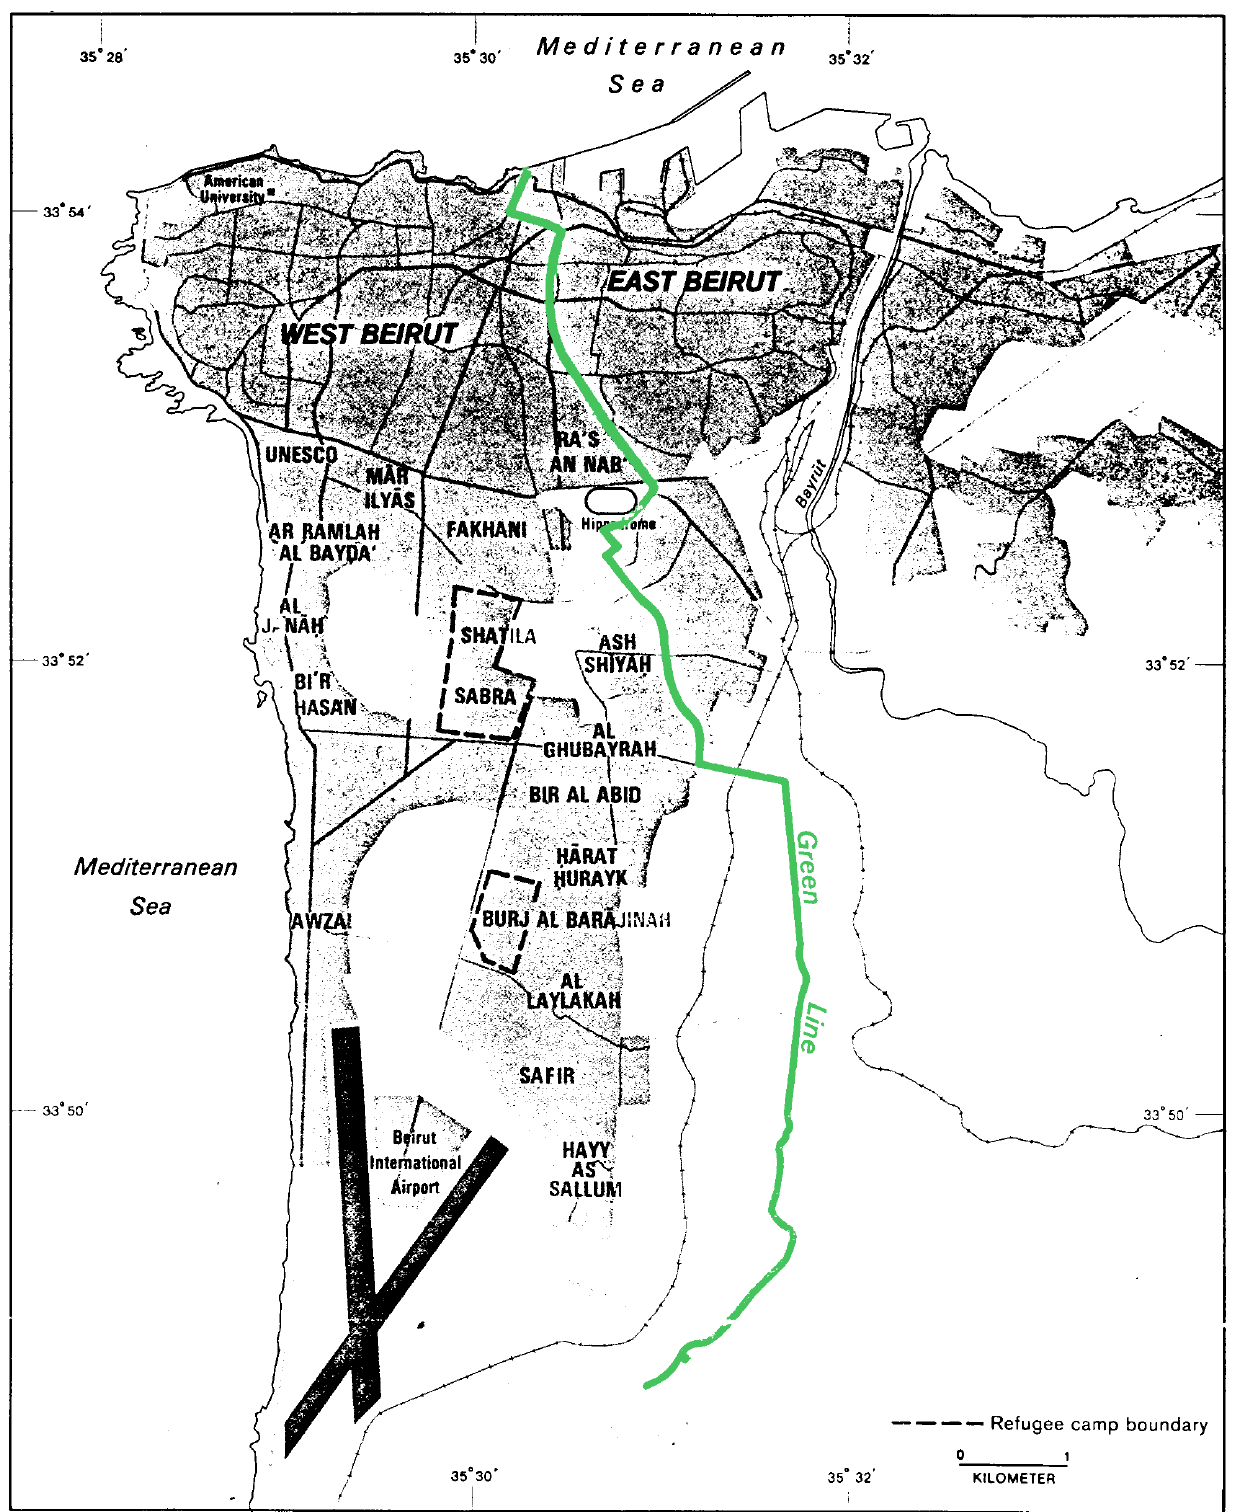
Figure 1. Map of neighbourhoods in Beirut in 1986, which also shows the Green Line. Source: U.S. Central Intelligence Agency in Wikimedia